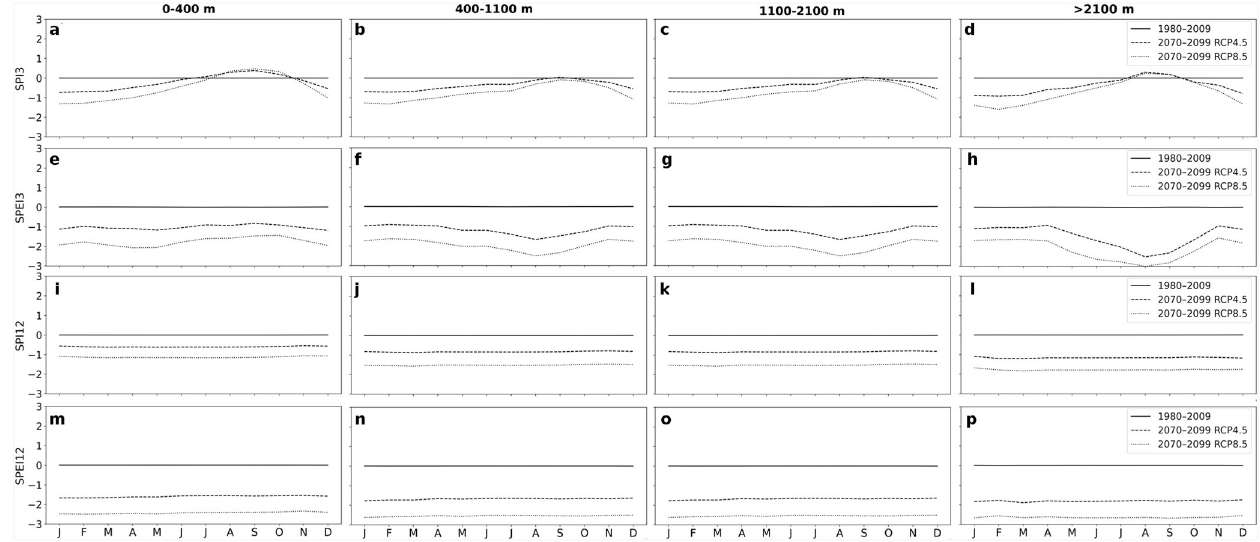
Fig. 3 Annual SPI and SPEI cycle for recent past and future projections by altitude levels. Annual cycle of SPI and SPEI at 3- ( a – h ) and 12-month ( i – p ) time scales for 30-year period simulations: recent past (1980 – 2009) and future 2070 – 2099, scenarios RCP4.5 and 8.5, at the four altitude intervals analyzed: 0-400 m ( a , e , i , m ), 400-1100 m ( b , f , j , n ), 1100-2100 ( c , g , k , o ), and >2100 m ( d , h , l , p ). The ensemble means are